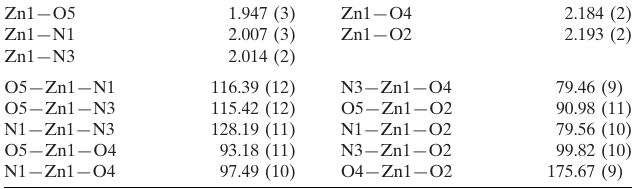
Selected geometric parameters (A˚ , (cid:2) ).